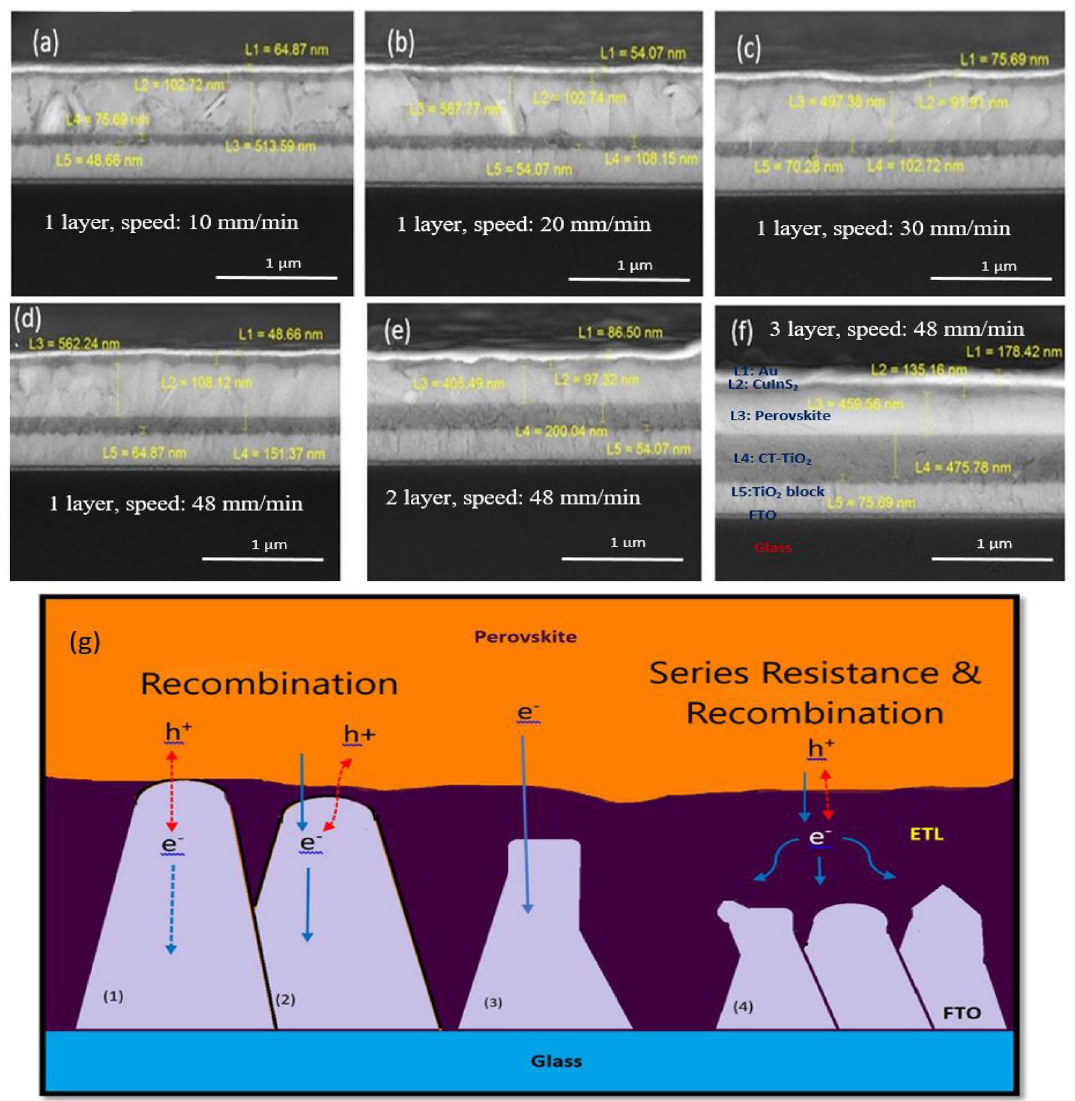
Figure 4. ( a – f ) Cross-sectional FE-SEM images of perovskite devices with different thicknesses of ETL including a configuration of FTO/TiO 2 block layer/TiO 2 layer/Cs 0.05 (MA 0.17 FA 0.83 ) 0.95 Pb(I 0.83 Br 0.17 ) 3 /CIS/ Au. ( g ) Electron transfer and electron transport mechanisms in different thicknesses of ETL. (1) No ETL (e − (FTO) + h + (perovskite)), (2) ultra-thin ETL, (3) ideal thickness of ETL (best performance), (4) ultra-thick ETL, and (e − (ETL) + h + (perovskite)).